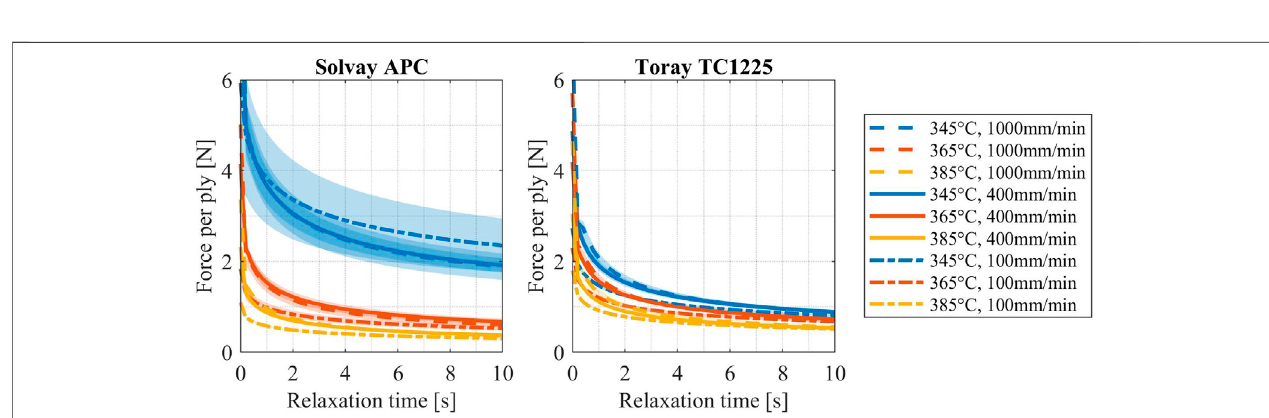
FIGURE 11 | Relaxation of the force per ply over time after the bias extension test. The shaded areas indicate one standard deviation around the mean based on three measurements.